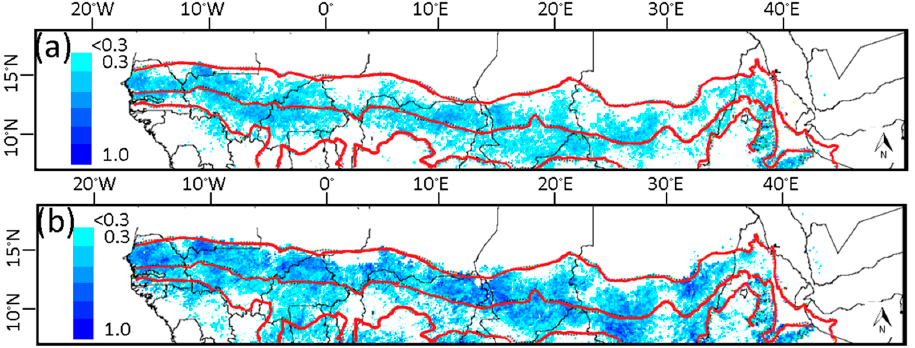
Figure 4. Coefficients of determination (r 2 ) for ( a ) annual rainfall- Σ NDVI and ( b ) growing season rainfall- Σ NDVI regressions. The red lines from north to south are the 300 mm, 700 mm and 1100 mm rainfall isohyets.